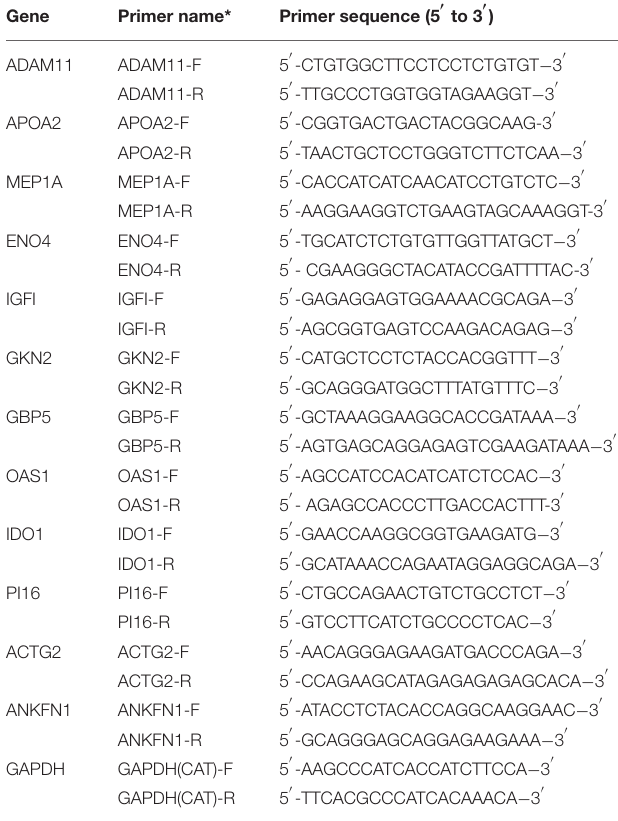
TABLE 1 | Gene names and primers used in qRT-PCR